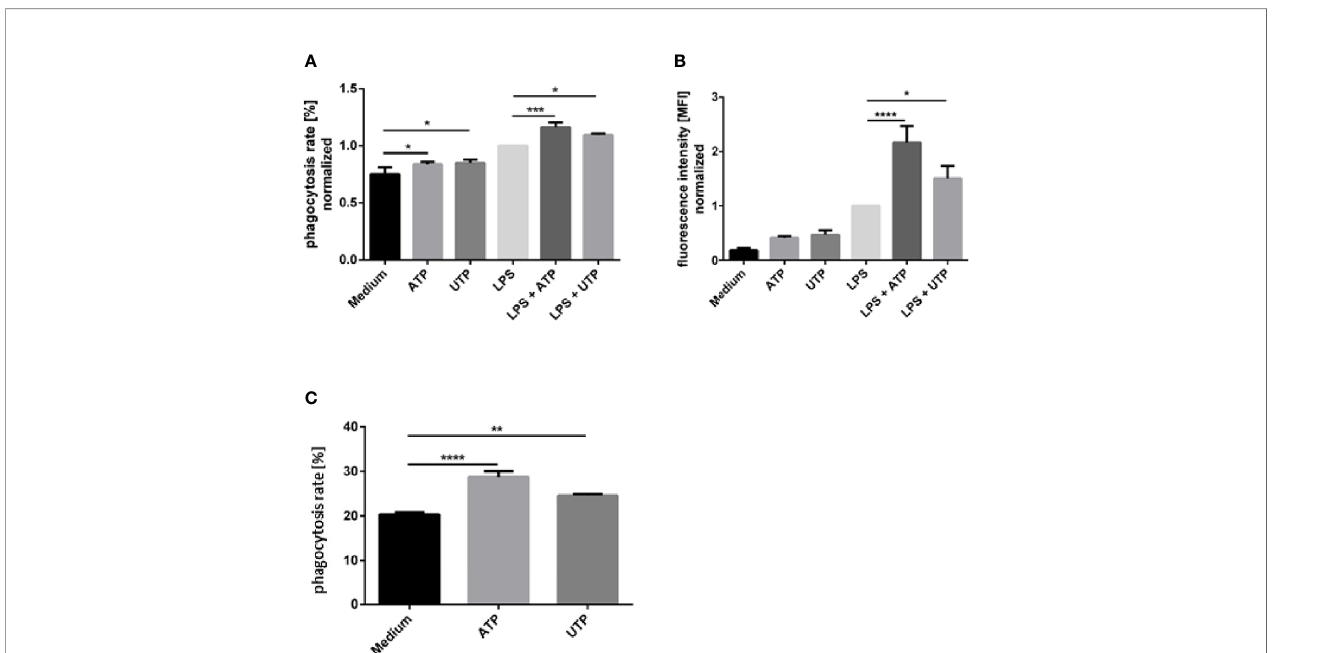
FIGURE 3 | The effect of extracellular ATP and UTP on the phagocytic capacity of neutrophils. (A, B) Neutrophils were exposed to of ATP (500 µM) or UTP (500 µM) in the presence or absence of LPS (100 ng/ml) or left untreated. FluoSphere carboxylate-modi fi ed latex microspheres with a diameter of 1 m m were added and incubated for 30 min. Phagocytosis was assessed by fl ow cytometry by analyzing the ratio (%) of neutrophils with ingested fl uorescent beads (A) and mean fl uorescence intensity (MFI) of cells that phagocytosed beads (B) . (C) Neutrophils were co-incubated with CFSE-labeled L. donovani promastigotes for 120 min at a neutrophil to Leishmania ratio of 1:5. Phagocytosis was assessed by fl ow cytometry by analyzing the ratio (%) of neutrophils with ingested CFSE-labeled Leishmania . Statistical analysis by ordinary one-way ANOVA with a post hoc Turkey ’ s test. n=3, *p ≤ 0,05, **p ≤ 0,01, ***p ≤ 0,001, ****p ≤